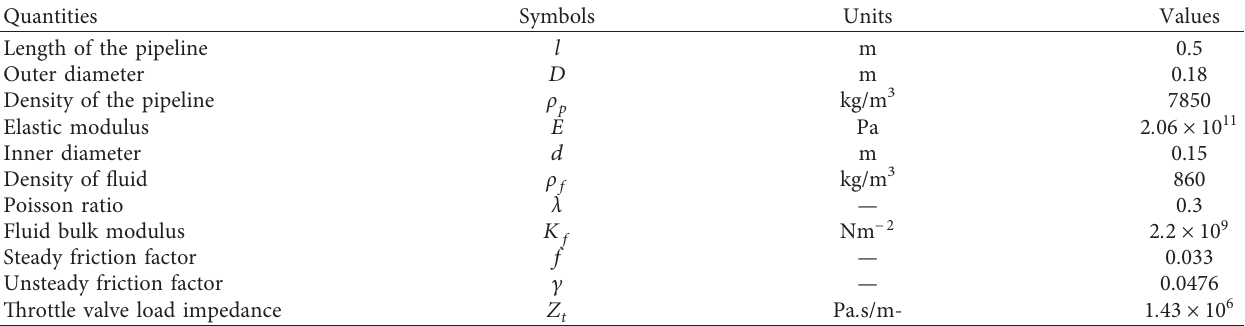
Table 2: The material and geometric details of the pipeline.